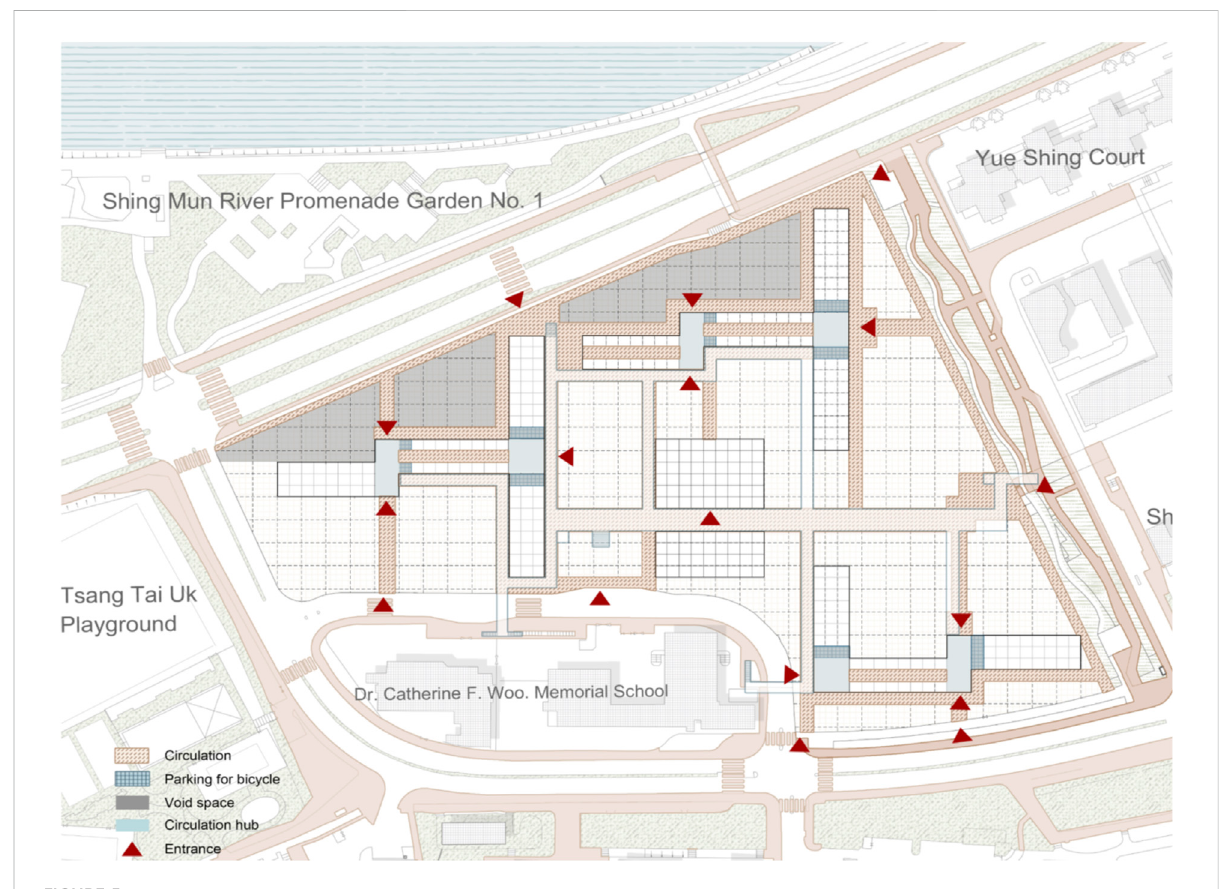
FIGURE 5 The game board of JMC housing estate during our phase 1 initial testing.